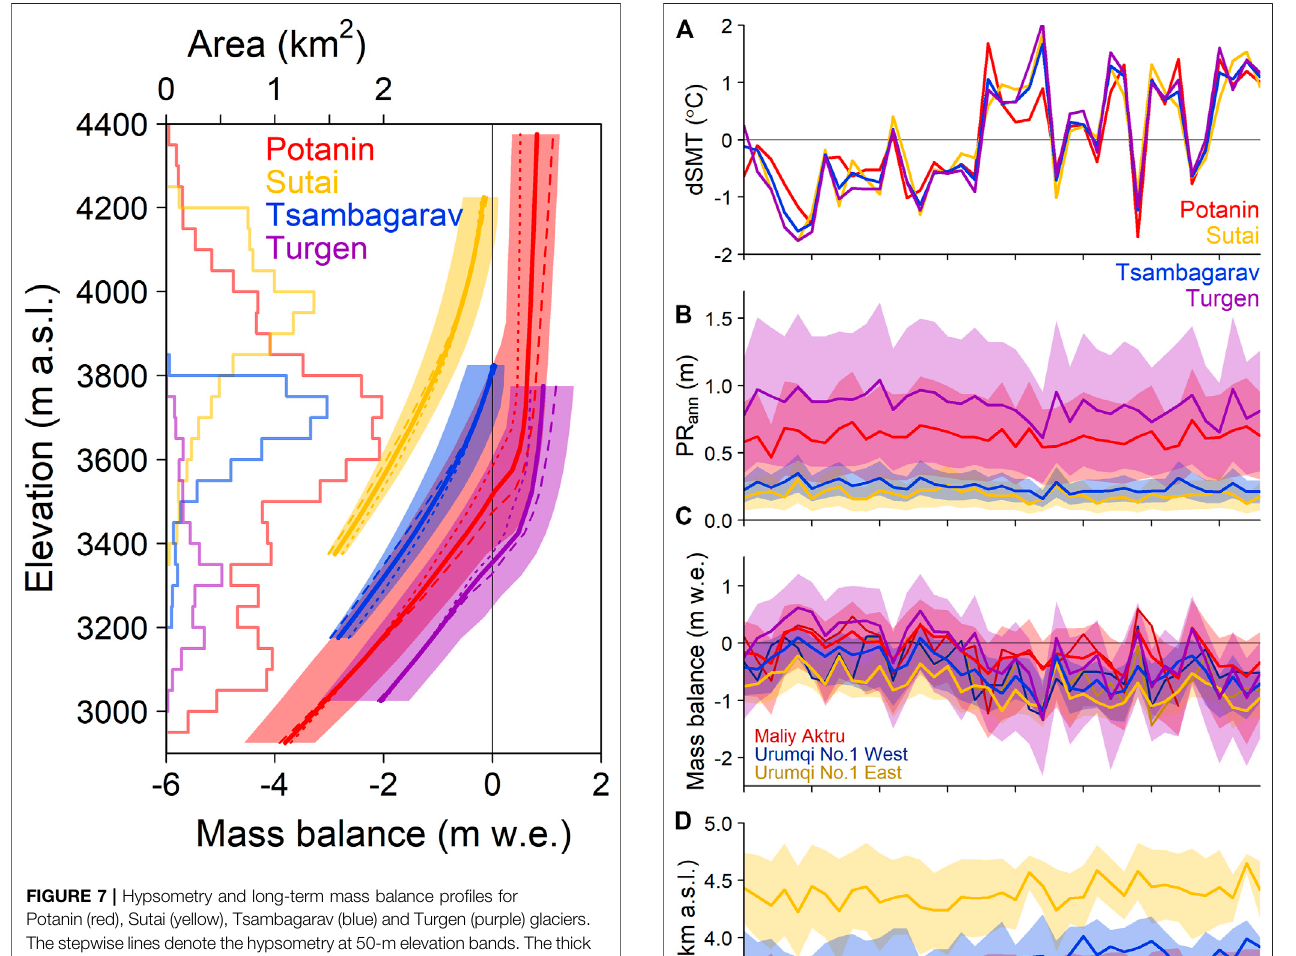
Frontiers in Earth Science |